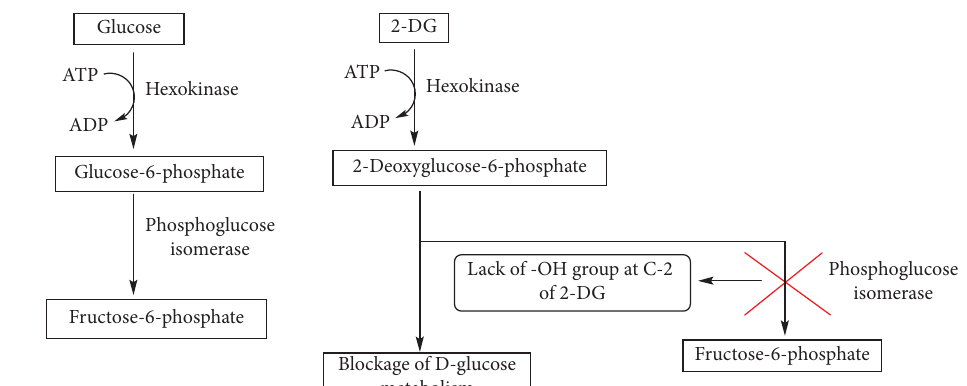
Figure 3: Mechanism of action of 2-DG.